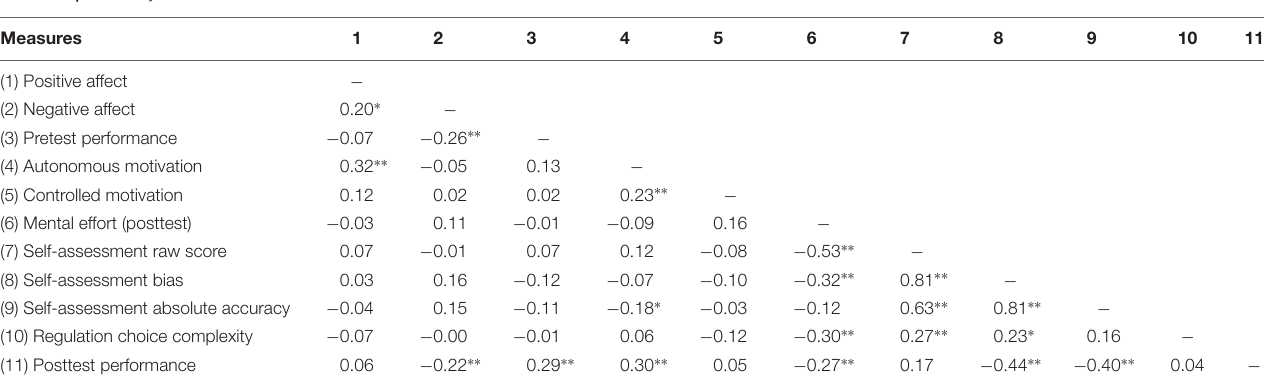
TABLE 2 | Summary of intercorrelations between measures.